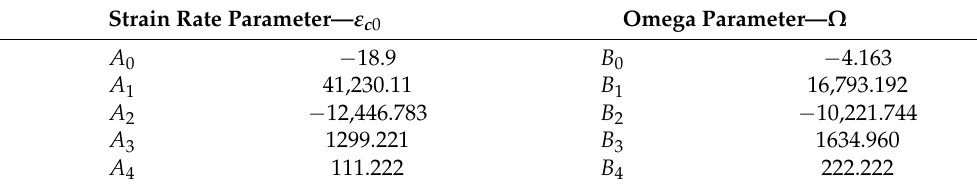
Table 1. MPC Omega model material coefficients for material type SS-316 (MPa, ◦ C) [43]. Strain Rate Parameter— ε c 0 Omega Parameter—